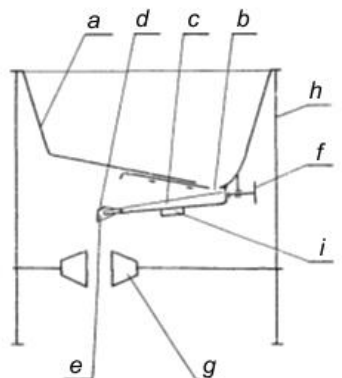
Figure 1. Light treatment device: a—hopper, b—outlet, c—chute, d—adjustable element, e—gap, f—adjustment screw, g—halogen floodlights, h—cover, i—vibration actuator.